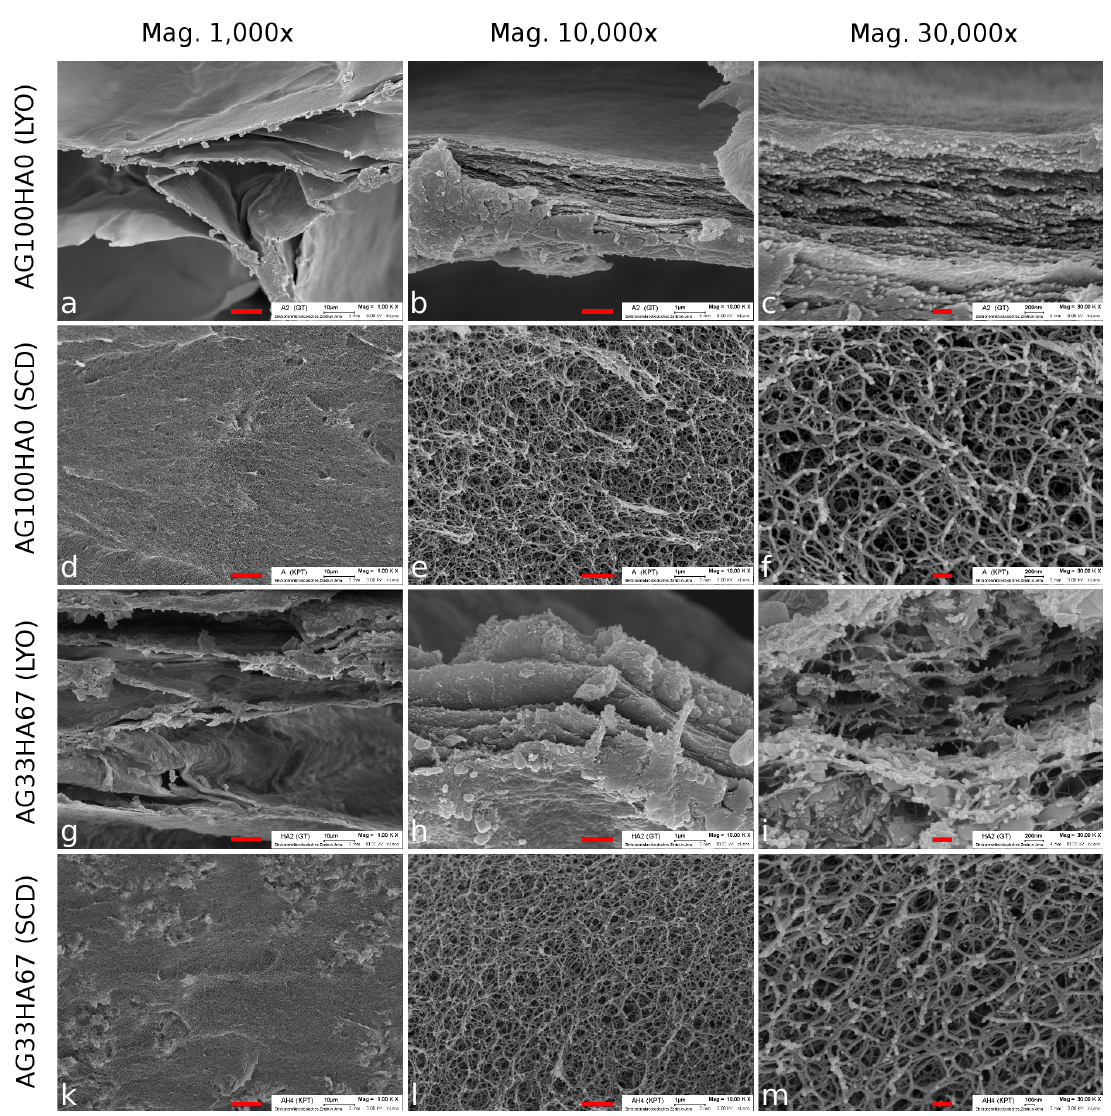
Figure 3. SEM images of agarose lyophilized (LYO; ( a – c )) and supercritically-dried (SCD; ( d – f )) and AG33HA67 composite LYO ( g – i ) and SCD ( k – m ) at three different magnifications. The scale bar is 10µm (left), 1µm (middle), and 0.2µm (right),